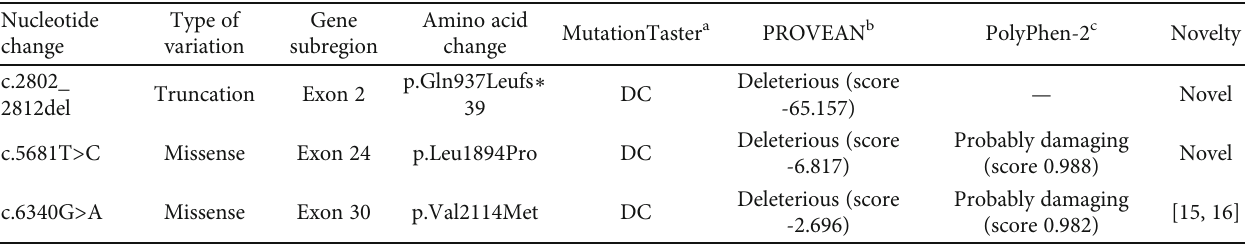
Table 2: Identi fi ed pathogenic variants in the MYO15A gene in this study and their prediction results by computer